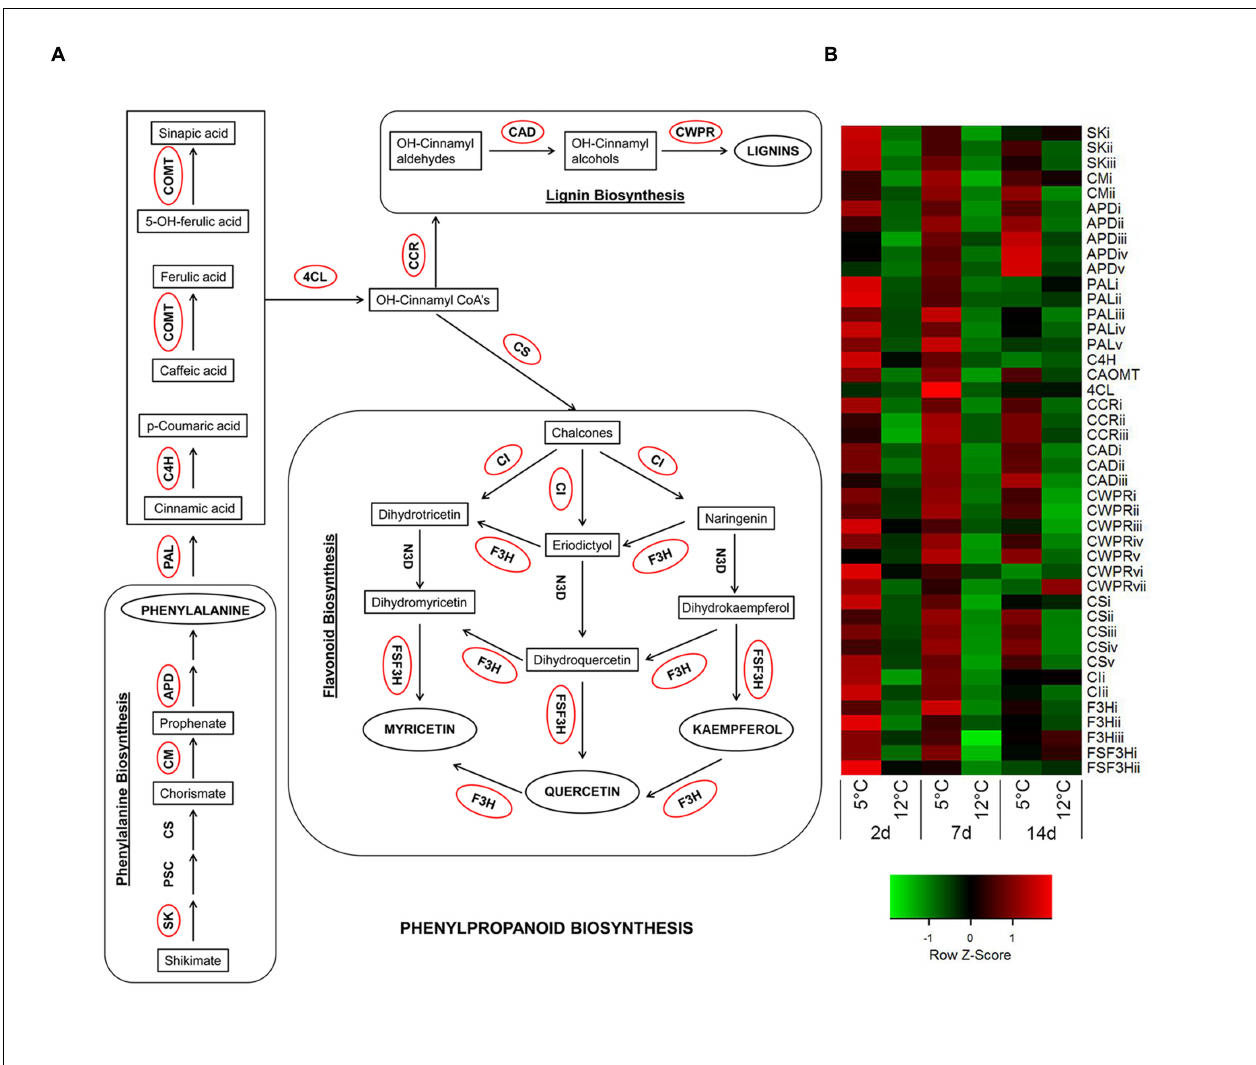
FIGURE 6 | Activation of phenylpropanoid-biosynthesis pathway in response to cold storage. (A) Major connections of phenylalanine biosynthesis to phenylpropanoid-, flavonoid-, and lignin-biosynthesis pathways based on the KEGG pathway mapper. Genes circled in red are significantly upregulated during cold storage at 5 ◦ C. (B) Expression heat map of genes related to phenylpropanoid-biosynthesis pathway at two different storage temperatures (5 and 12 ◦ C) at different sampling times (2, 7, and 14 days). Z -scores represent rescaled log fold change values. Abbreviations, transcript identification and expression profile are described in Supplementary Table S2